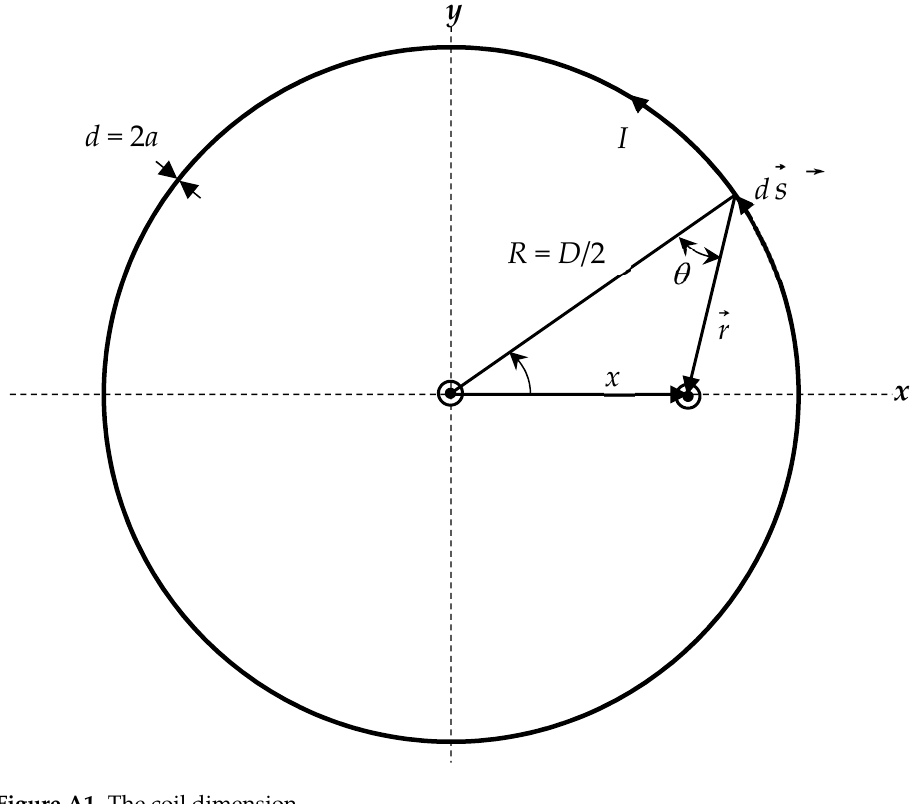
Figure A1. The coil dimension. Table A1. Measured three inductors with different